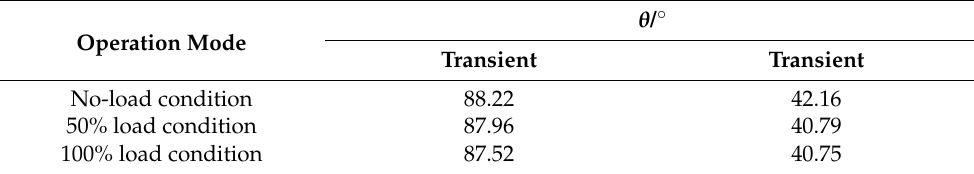
Table 6. Fault-type identification test results under different fault